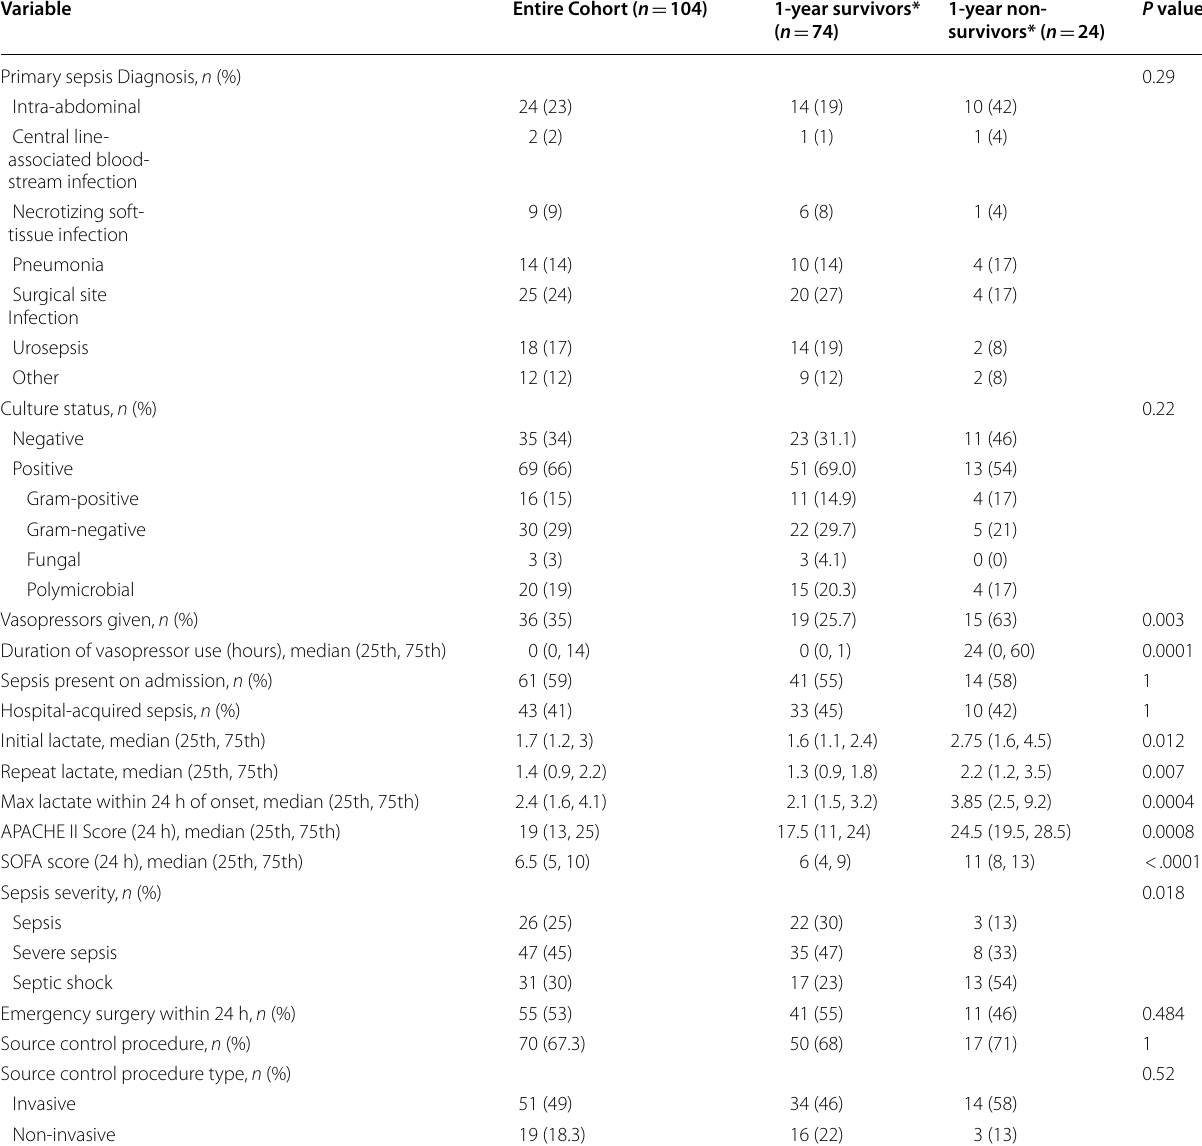
*indicate that 6 patients were lost to follow up and did not have data on 1-year